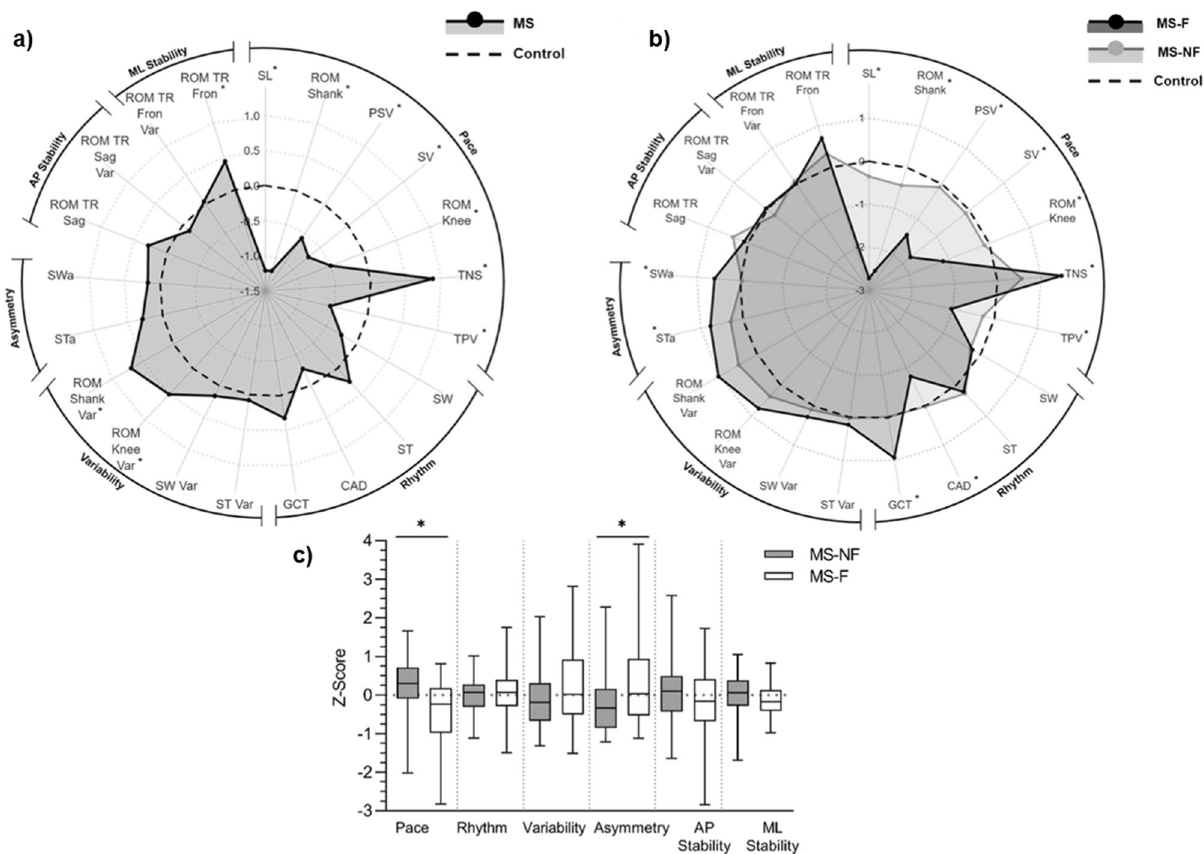
Figure 2. Radar plots illustrating the pattern of gait impairment between PwMS and controls (a) and between MS-fallers (MS-F) and MS non-fallers (MS-NF) (b) . Data reflect mean values. The central dashed line represents control data. Deviations from zero along the axes indicate the number of standard deviations the MS groups differ from controls. MS gait outcomes were converted to z-scores based on control means and standard deviations. Gait variables are organized by the domains produced in the PCA analysis. (c) Represents composite domain scores between MS-F and MS-NF produced by averaging the standardized gait parameters in each domain.* indicates differences between fallers and non-fallers. * indicates a statistical difference) at the p < 0.05 level. SL stride length; ROM Shank range of motion shank; PSV peak swing velocity; SV stride velocity; ROM Knee range of motion knee; TNS turn the number of steps; TPV turn peak velocity; SW swing time; ST stance time; CAD cadence; GCT gait cycle time; ST Var stance time variability; SW Var swing time variability; ROM Knee Var range of motion knee variability, ROM Shank Var range of motion shank variability; STa stance time asymmetry; SWa swing time asymmetry; ROM TR Sag trunk sagittal range of motion; ROM TR Sag Var trunk sagittal range of motion variability; ROM TR Fron trunk frontal range of motion; ROM TR Fron Var trunk frontal range of motion